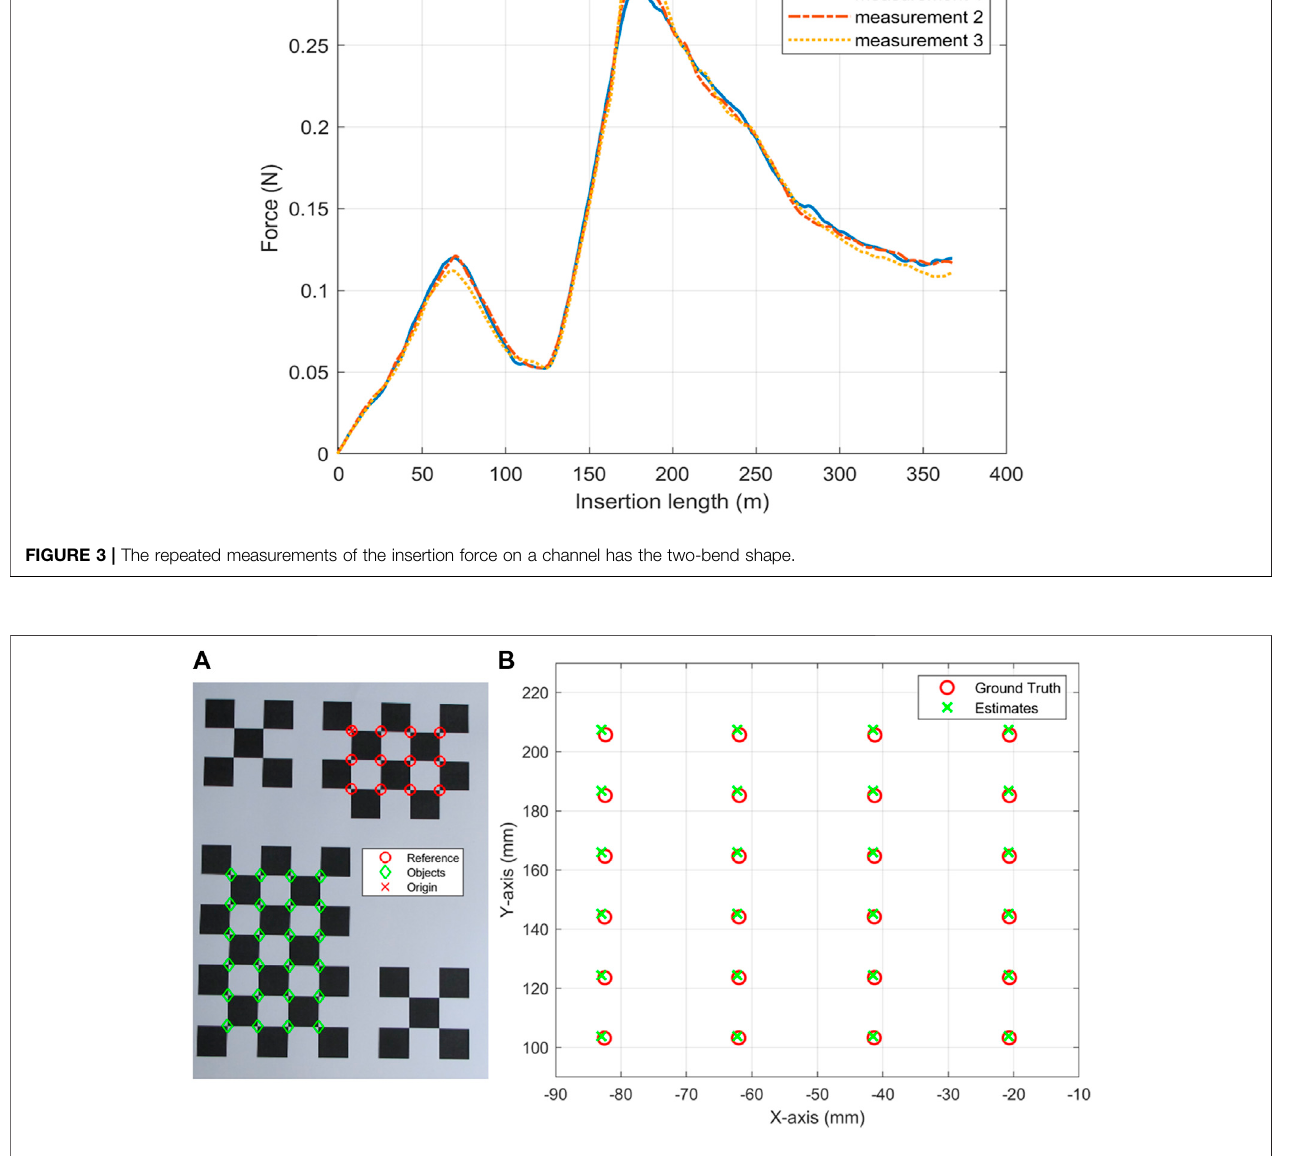
FIGURE 4 | (A) checkerboards to check the accuracy of image measurement, (B) the ground truth and estimates of the objects in (A) .